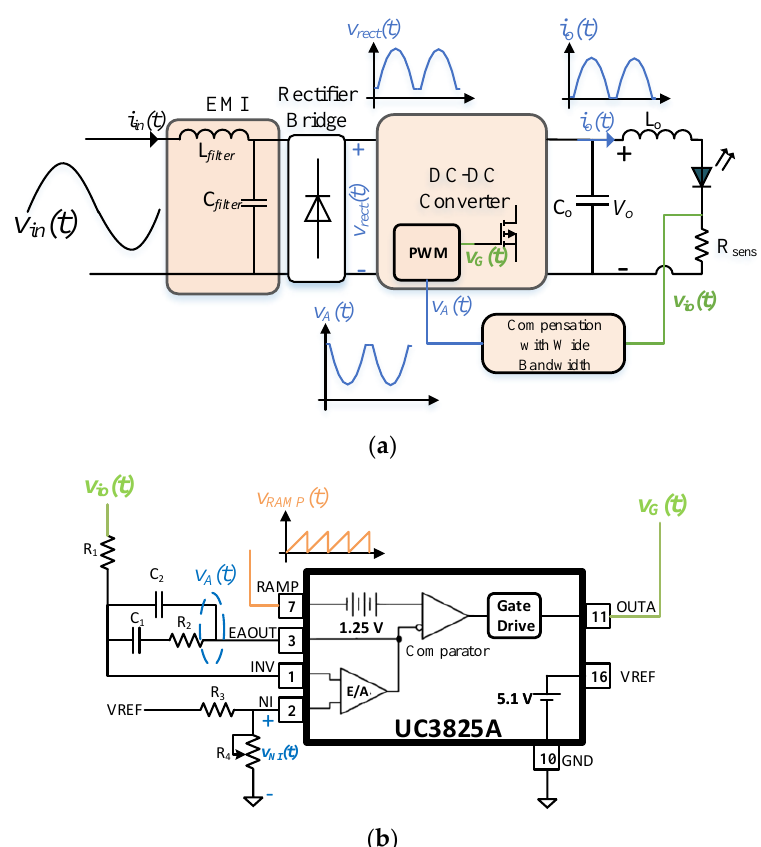
Figure 13. ( a ) Proposed circuit forharmonics injection. ( b ) Compensator circuit diagram for E-Cap less converter.